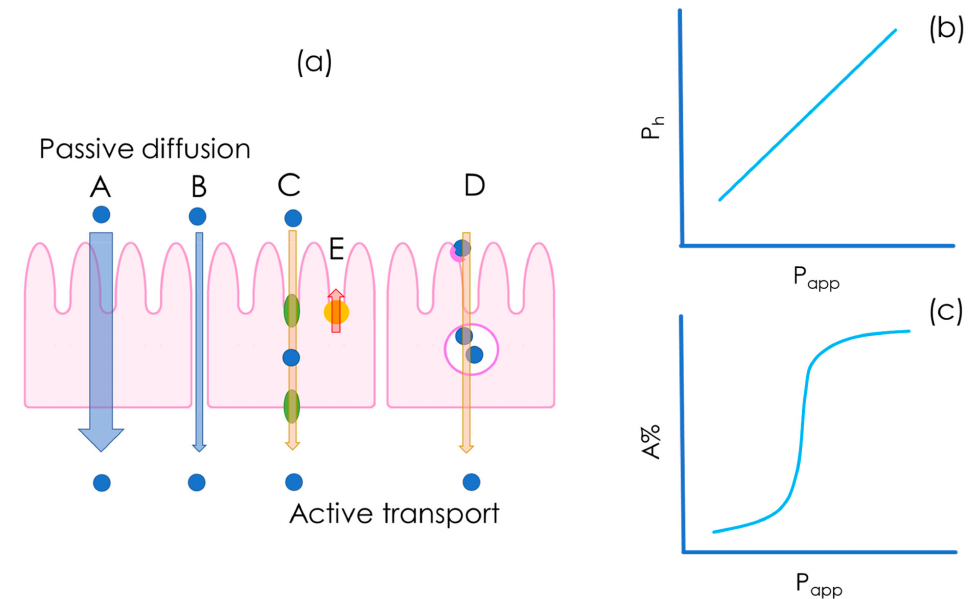
Figure 4. Pathways for drug absorption across an epithelial monolayer ( a ), the expected correlation between in vitro apparent permeability (P app ) and in vivo human permeability (P h ) ( b ), and the expected correlation between P app and the fraction absorbed (A%) ( c ). Drug absorption can occur via the transcellular route ( A ), the paracellular route ( B ), carrier-mediated transport ( C ), or transcytosis